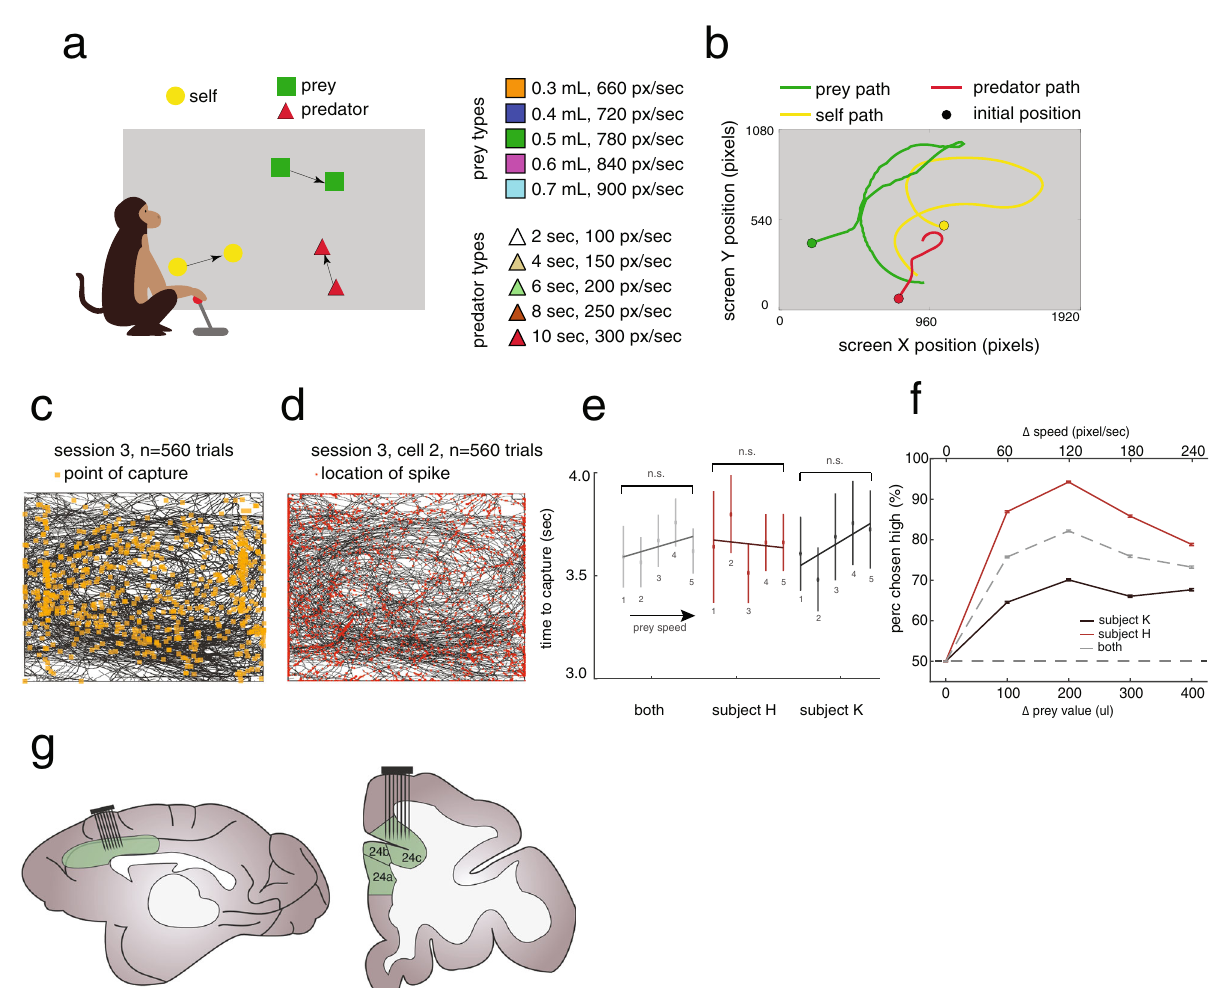
Fig. 1 Experimental paradigm and behavioral results. a Cartoon of the virtual pursuit task . Subject uses a joystick to control an avatar (circle) to pursue prey (square) and avoid predators (triangle). b Agent trajectories on example trial. c Illustration of typical session indicating subject ’ s path (black lines) and points of capture (orange dots). d Illustration of example session showing subjects ’ path (gray lines) and points of spiking (red dots). e Average time to capture for each subject as a function of value of prey. No signi fi cant relationships are observed despite large datasets. This lack of correlation suggests that subjects generally traded-off effort to maintain roughly constant pursuit duration. f The proportion of trials on which subjects chose the larger value prey item despite it being faster was >50% for each prey difference (other than matched). Error bars indicate the standard error of the mean. The total number of trials in each subject was 5002 across 19 experimental sessions for subject K, and 3094 across 5 experimental sessions for subject H. g Schematic of the macaque brain showing medial surface and coronal sections. We record primarily from the dorsal bank of the anterior cingulate sulcus at roughly the rostrocaudal position of the genu; we call this region area